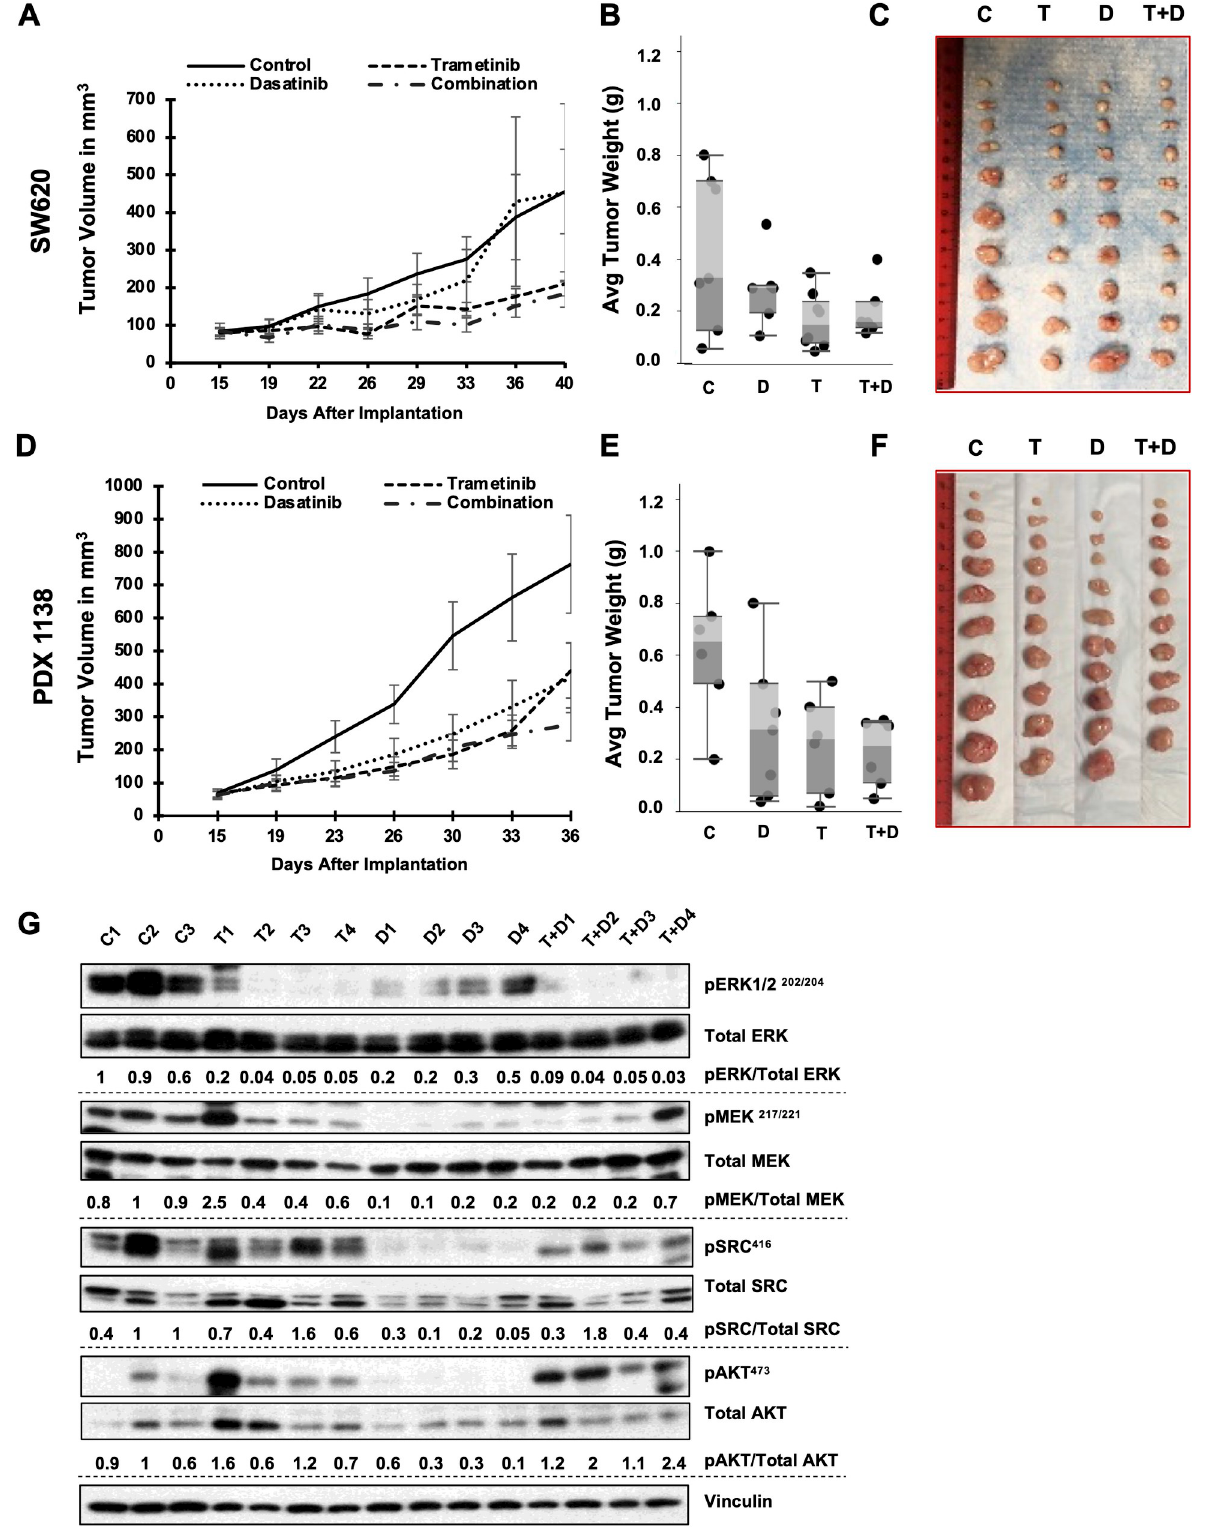
Fig 5. Combination with dasatinib does not significantly enhance the efficacy of trametinib in vivo . KRAS-mutated SW620 cells were grown subcutaneously in nude mice and subjected to treatment with vehicle (control), dasatinib (30 mg/kg), trametinib (0.3 mg/kg), or dasatinib and